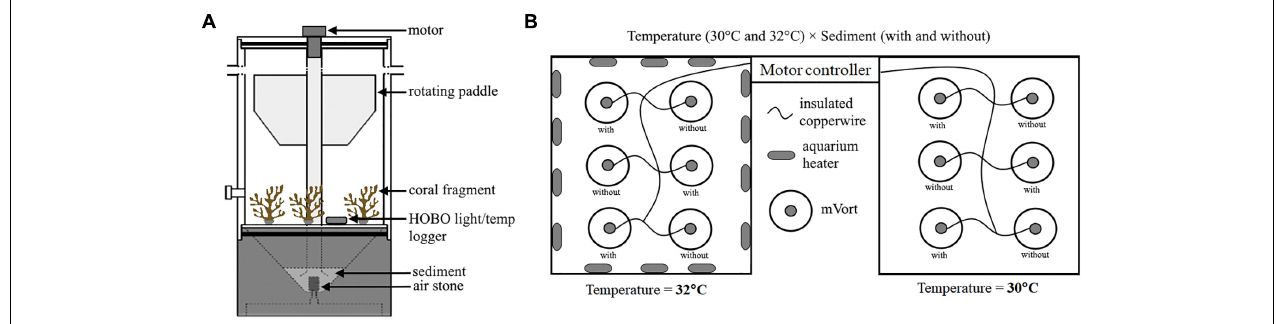
FIGURE 1 | Experimental setup showing (A) mini-Vortex resuspension tank (mVort) which was used to simulate sediment stress event and contained three P. acuta fragments from different genotypes; and (B) Two separate water baths containing the mVorts which were held at two temperature levels (30 and 32 ◦ C). In each water bath, three mVorts were exposed to sediment (i.e., with sediment) while the other 3 were not (i.e., without sediment).